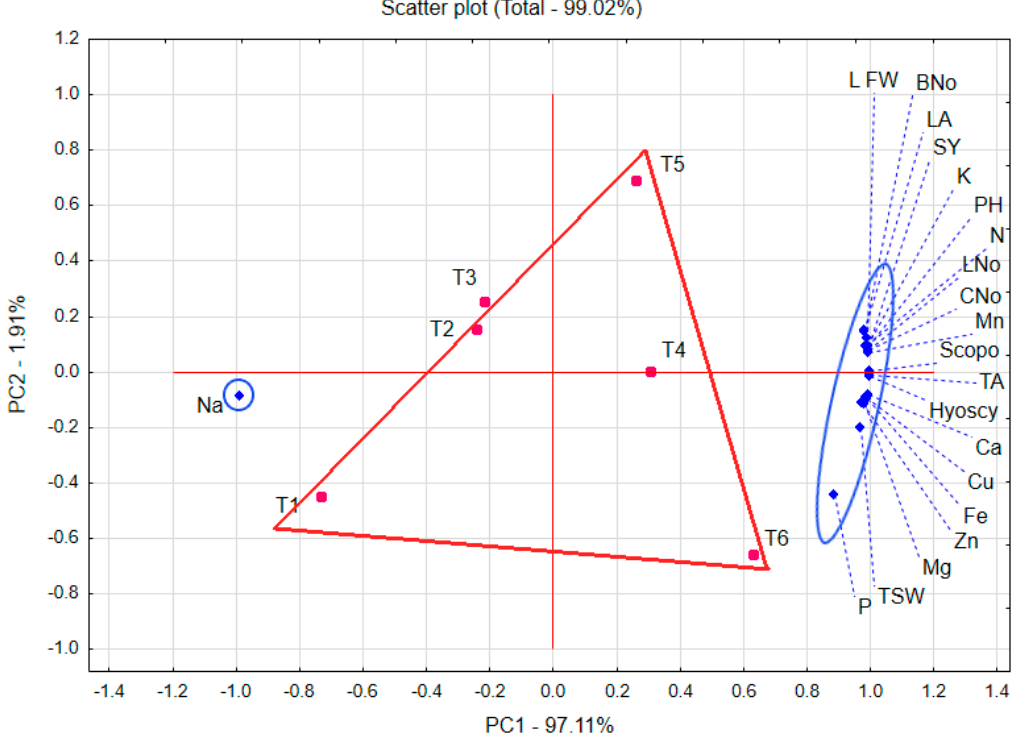
Figure 3. Treatment ordination by trait biplots of principal component analysis outputs of Egyptian henbane research trials. T1, 30 kg N ha − 1 without Rhizobacterein (30N × RB − ); T2, 30 kg N ha − 1 with Rhizobacterein (30N × RB + ); T3, 60 kg N ha − 1 without Rhizobacterein (60N × RB − ); T4, 60 kg N ha − 1 with Rhizobacterein (60N × RB + ); T5, 120 kg N ha − 1 without Rhizobacterein (120N × RB − ); T6, 120 kg N ha − 1 with Rhizobacterein (120N × RB + ). PH, plant height; BNo, number of branches per plant; LA, total leaf area per plant; LFW, fresh weight of leaves per plant; N, nitrogen; P, phosphorus; K, potassium; Ca, calcium; Na, sodium; Fe, iron; Zn, zinc; Mn, manganese; Cu, copper; Hyoscy, hyoscyamine; Scopo, scopolamine; CNo, capsule number per plant; TSW, 1000-seed weight; SY, seed yield per plant.